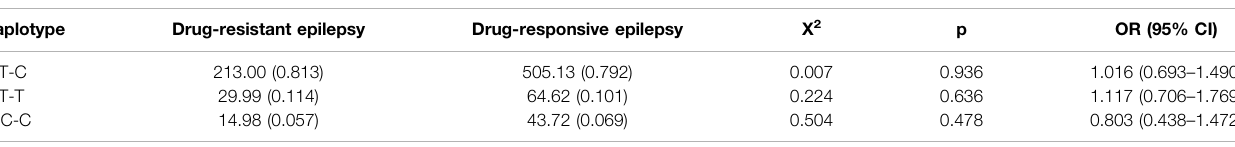
TABLE 7 | Association between Haplotypes of STX1B SNPs and drug-resistant epilepsy risk. Haplotype